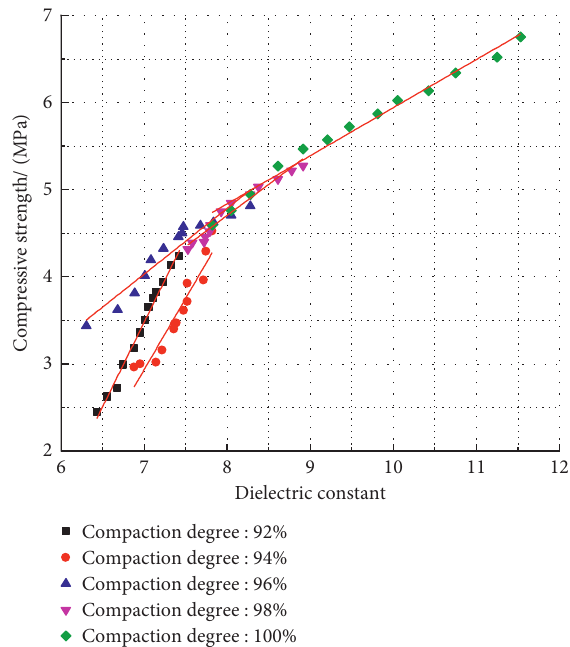
Figure 6: Relationship between the dielectric constant and strength of fine specimens.